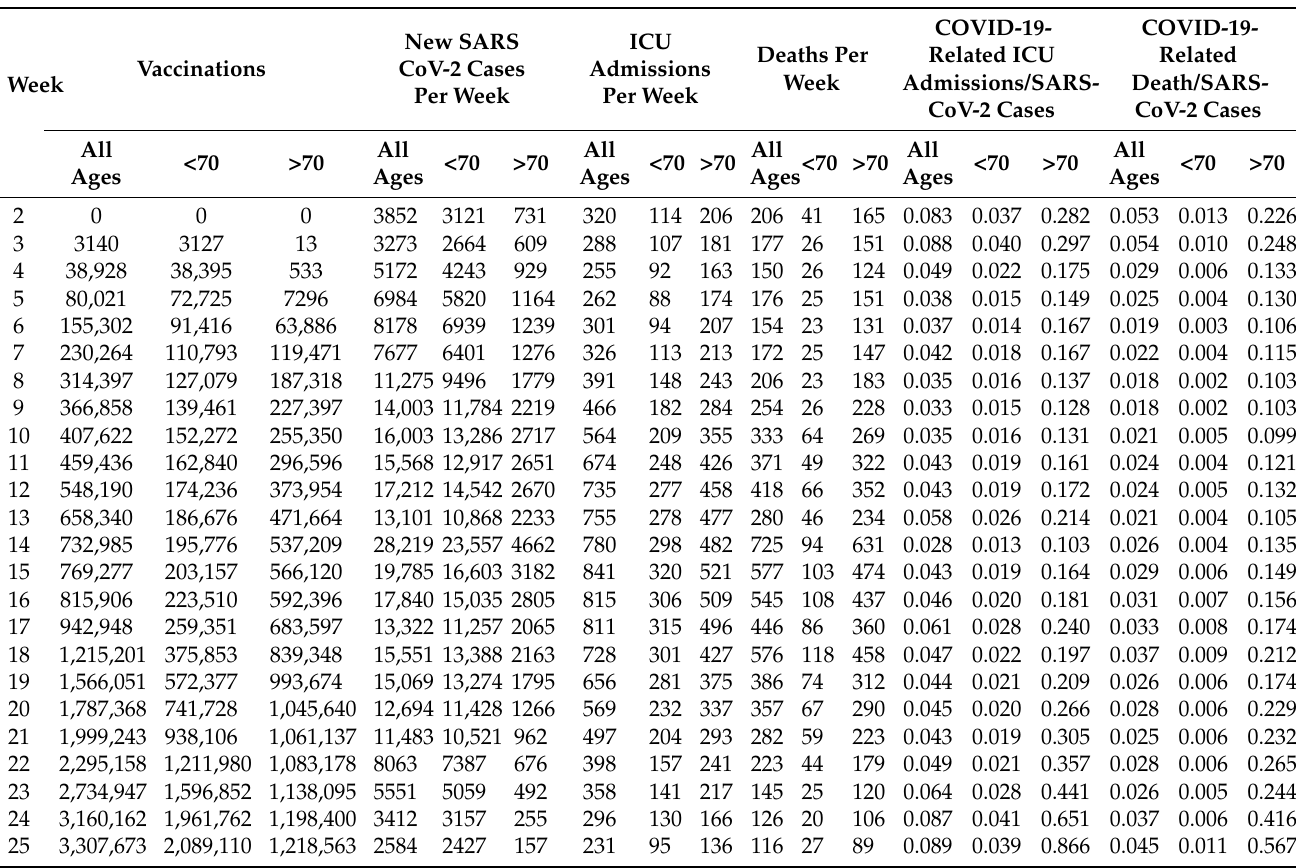
Table 1. Weekly distribution of vaccinations, new SARS-CoV-2 cases, ICU admissions due to COVID- 19, COVID-19-related deaths and the ratio of COVID-19-related ICU admissions/SARS-CoV-2 cases and the ratio of COVID-19-related deaths/SARS-CoV-2 cases. The data on vaccinations are presented cumulatively. The data are presented as absolute